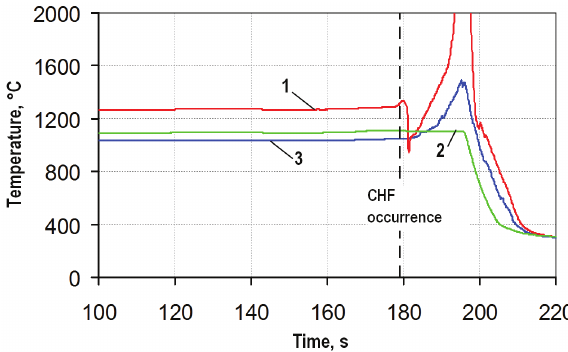
Figure 4. The temperature in the center of the fuel element ker- nel at the final stage of heating (the 0 s mark corresponds to a time of 12 h 41 min 32 s in the graph of Fig. 3): 1. TC T read - 1 ings; 2. TC T readings; 3. TC T 2 3